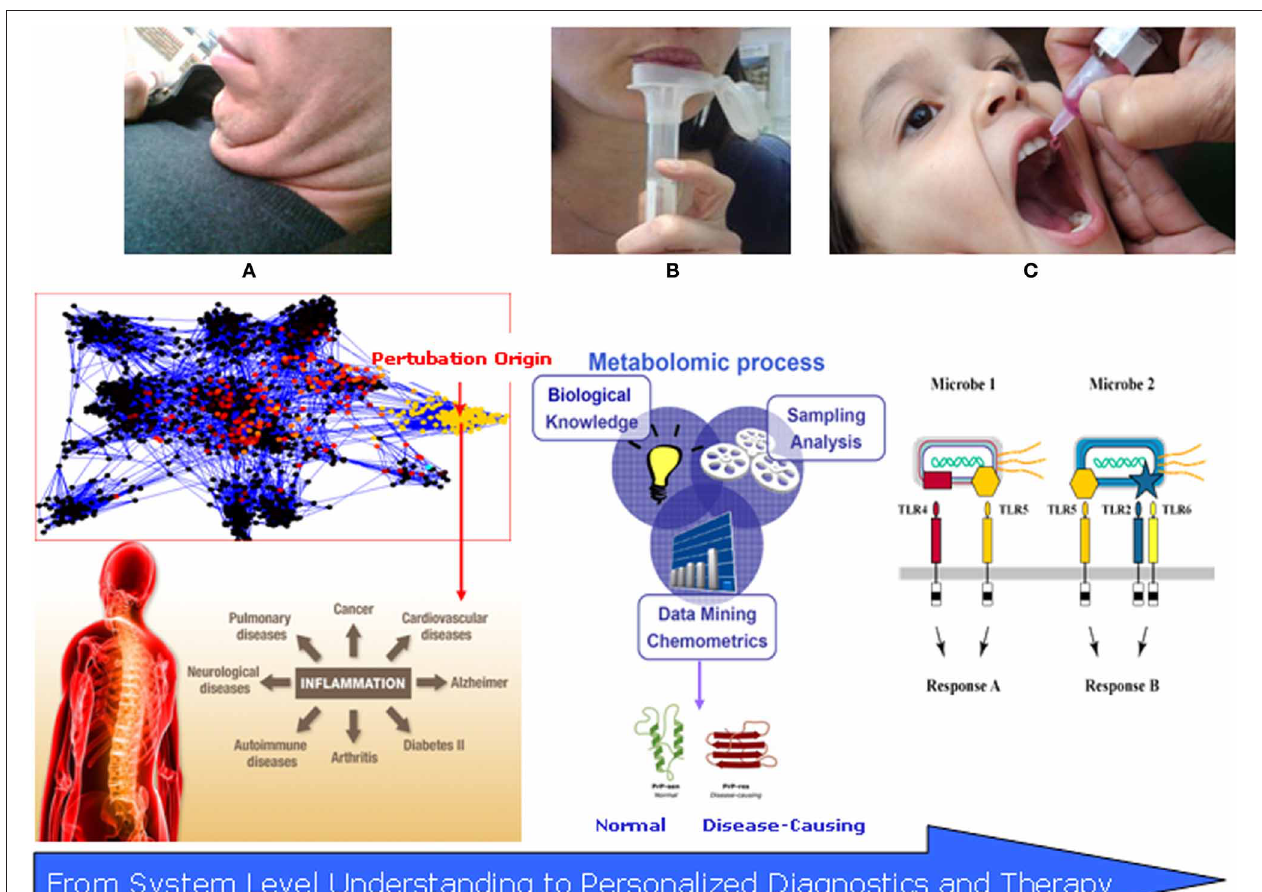
FIGURE 2 | Translational systems medicine: salivomics and vaccinomics of the oral microbiome. (A) The “Fatty Neck”—new emerging marker of inflammatory complications; (B) Salivary diagnostics (salivomics)—non-invasive and applicable approach for disease detection